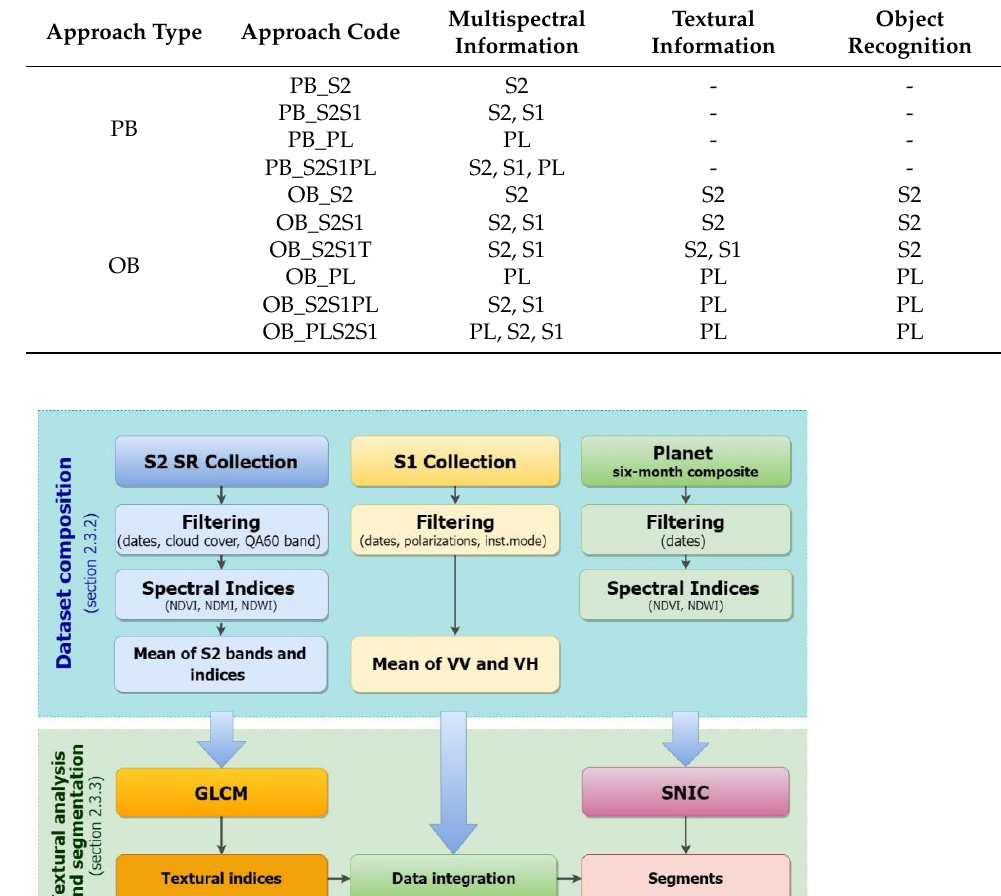
Table 2. Sources of multispectral and textural information and datasets used for object recognition in the various approaches compared in the research. PB: pixel-based, OB: object-based, S2: Sentinel 2, S1: Sentinel 1, PL: PlanetScope.